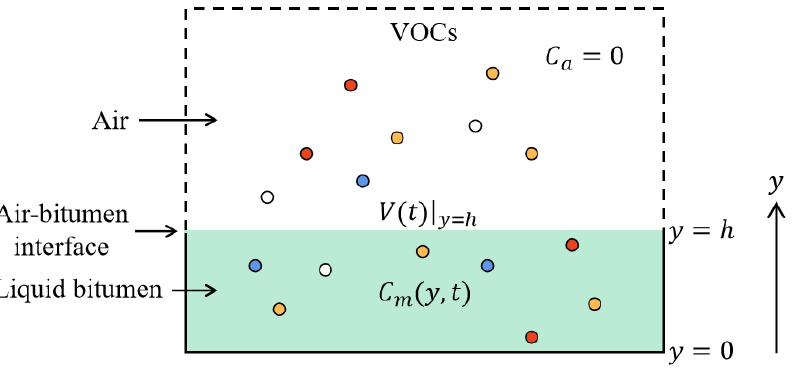
Figure 12. Schematic diagram of VOCs emission from bitumen into the air.